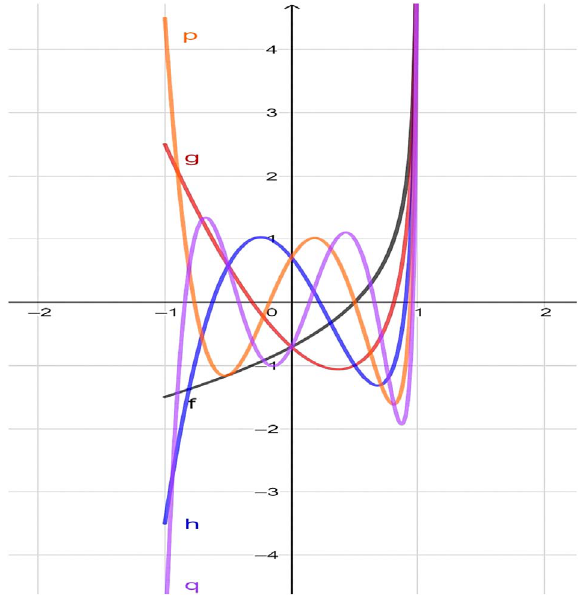
Figure 10. V k +1/2 ( x ), k = 1, 2, 3, 4, 5. (1) Grey; (2) red; (3) blue; (4) orange; (5)